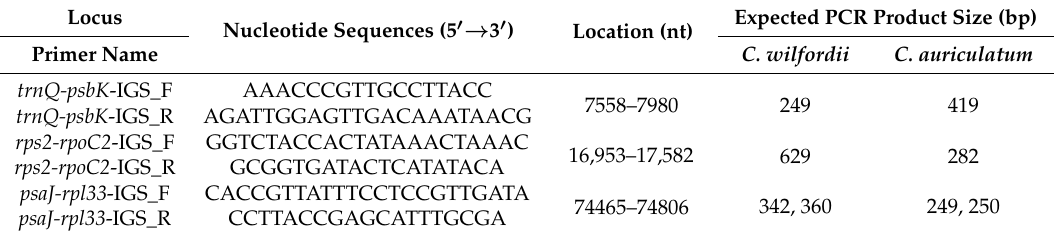
Figure 2. Multiple sequence alignment of five C. wilfordii and C. auriculatum chloroplast genomes derived from NCBI genbank using CLC Sequence Viewer 8 program. Multiple sequence alignments showed the three InDel regions with the possibility of candidate molecular markers. ( A ) InDels were observed in IGS region between trnQ and psbK genes. ( B ) InDel was observed in IGS region between rps2 and rpoC2 genes. ( C ) InDels were observed in IGS region between psaJ and rpl33 genes. The red box denotes InDels. Table 1. InDel markers used in this